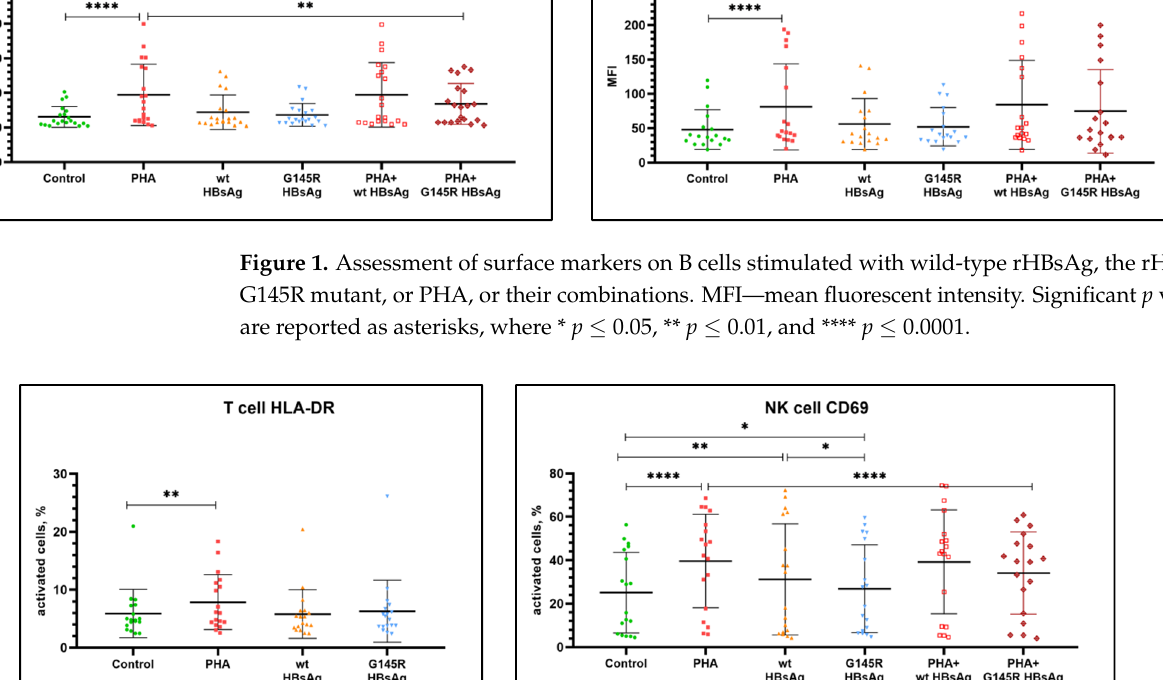
Figure 3. Assessment of surface markers on T cells stimulated with wild-type rHBsAg, the rHBsAg G145R mutant, or PHA, or their combinations. ( A )—CD4 + T cells, ( B )—CD8 + T cells. Significant p values are reported as asterisks, where * p ≤0.05, ** p ≤ 0.01, *** p ≤ 0.001, and **** p ≤ 0.0001. The positive control PHA stimulation caused a statistically significant increase in the expression of CD69, CD86, CD40, and HLA-DR on B cells; CD69 on NK and T cells (both CD4 + and CD8 + ), and HLA-DR on T cells. Wild-type rHBsAg caused a statistically significant increase in the expression CD86 and CD69 but no activation of other markers (CD40, HLA-DR) on B cells. Additionally, it caused a statistically significant increase in the expression CD69 on T cells and NK cells. There was no activation of HLA-DR or CD279 on T cells. rHBsAg with the G145R mutation had no statistically significant effect on the ex- pression of activation markers on PBMC from healthy donors except the expression of CD69 on all tested cells. However, the CD69 activation induced by the rHBsAg G145R mutant was weaker compared with wild-type rHBsAg. The data were significant for NK cells ( p = 0.0333), and a trend was observed for B cells, CD4 + T cells and CD8 + T cells ( p = 0.2774, p = 0.5519, and p = 0.1075, respectively). The effects of wild-type rHBsAg (ayw2) and rHBsAg with the G145R mutation (ayw2) on PHA-induced activation of PBMC from healthy donors were also evaluated, and the results are summarized in Table 2. Statistical analysis of the results was per- formed in comparison to the control PHA stimulation values.